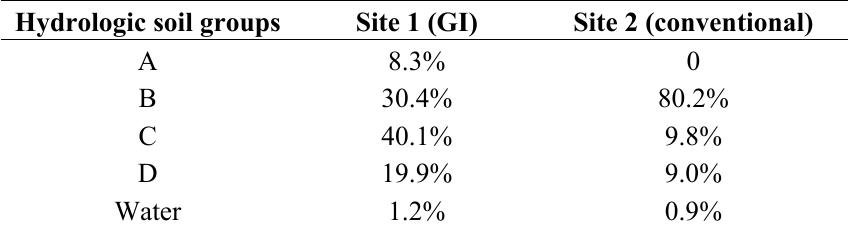
Table 2. Hydrologic soil groups in Site 1 (Panther Creek watershed, The Woodlands green infrastructure development) and Site 2 (Bear Creek watershed, conventional development).